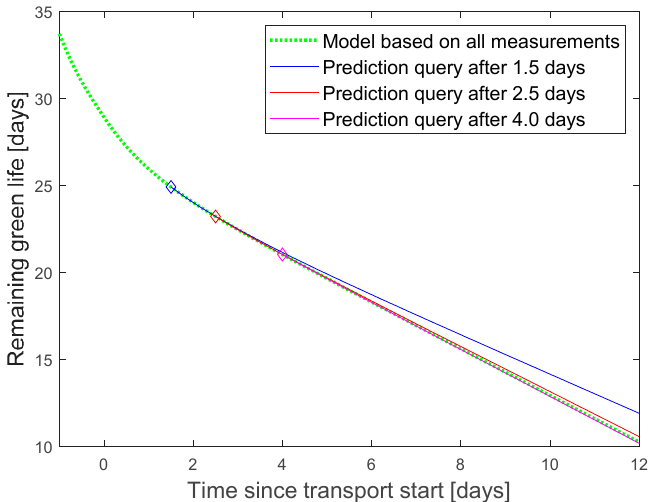
Figure 8. Green life prediction based on full temperature curve (dotted green) and predicted temperature for different query times. Supply air temperature assumed constant at 13.2 °C after the query.